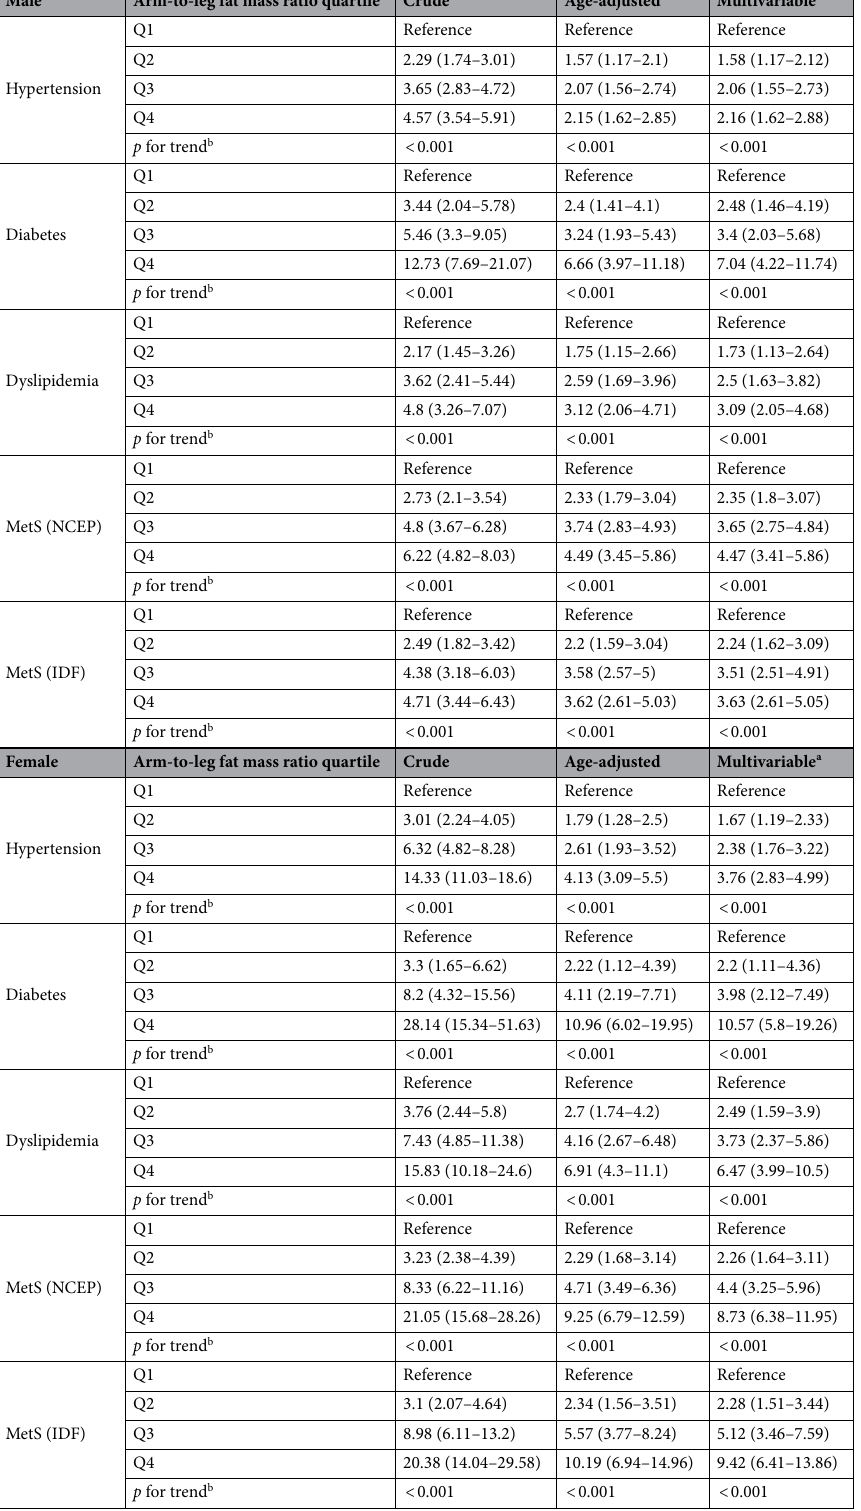
Table 3. Odds ratios for cardiovascular disease risk factors according to arm-to-leg fat mass ratio quartile. Data are presented as odds ratio (95% confidence interval). MetS, metabolic syndrome; NCEP, 2005 National Cholesterol Education Program Adult Treatment Panel III; IDF, 2006 International Diabetes Federation. a Multivariable model adjusted for age, energy intake, water intake per body weight, smoking, alcohol drinking, physical activity, education, income, and survey year. b Test for linear trend across quartile of arm-to-leg fat mass